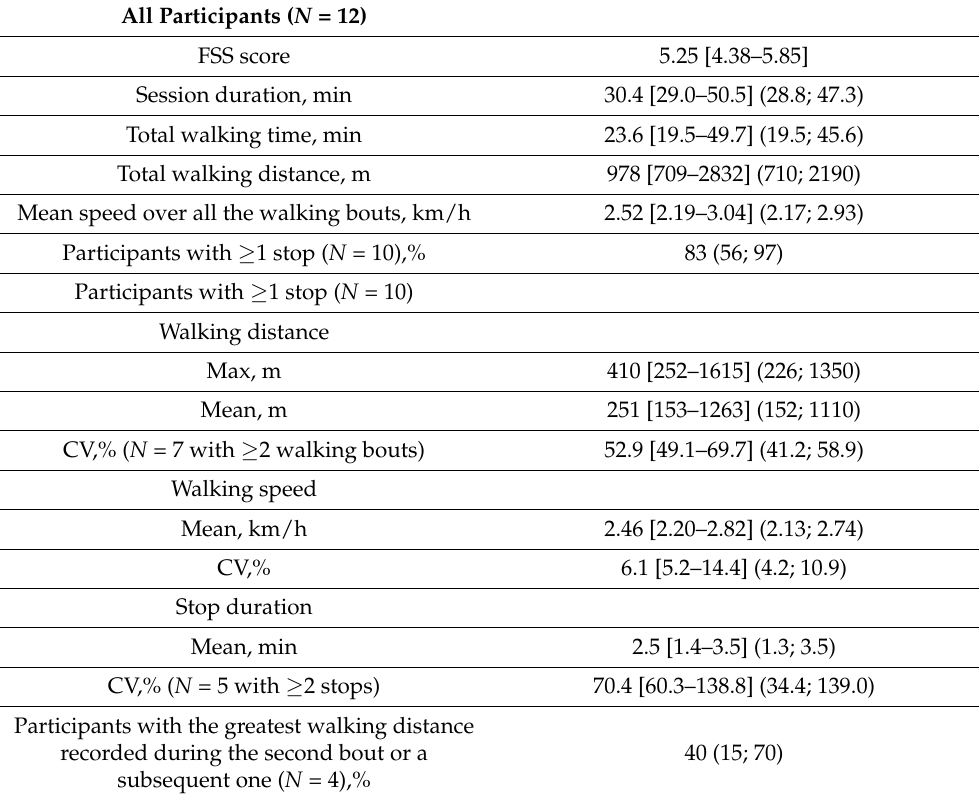
Table 2. GPS outdoor walking